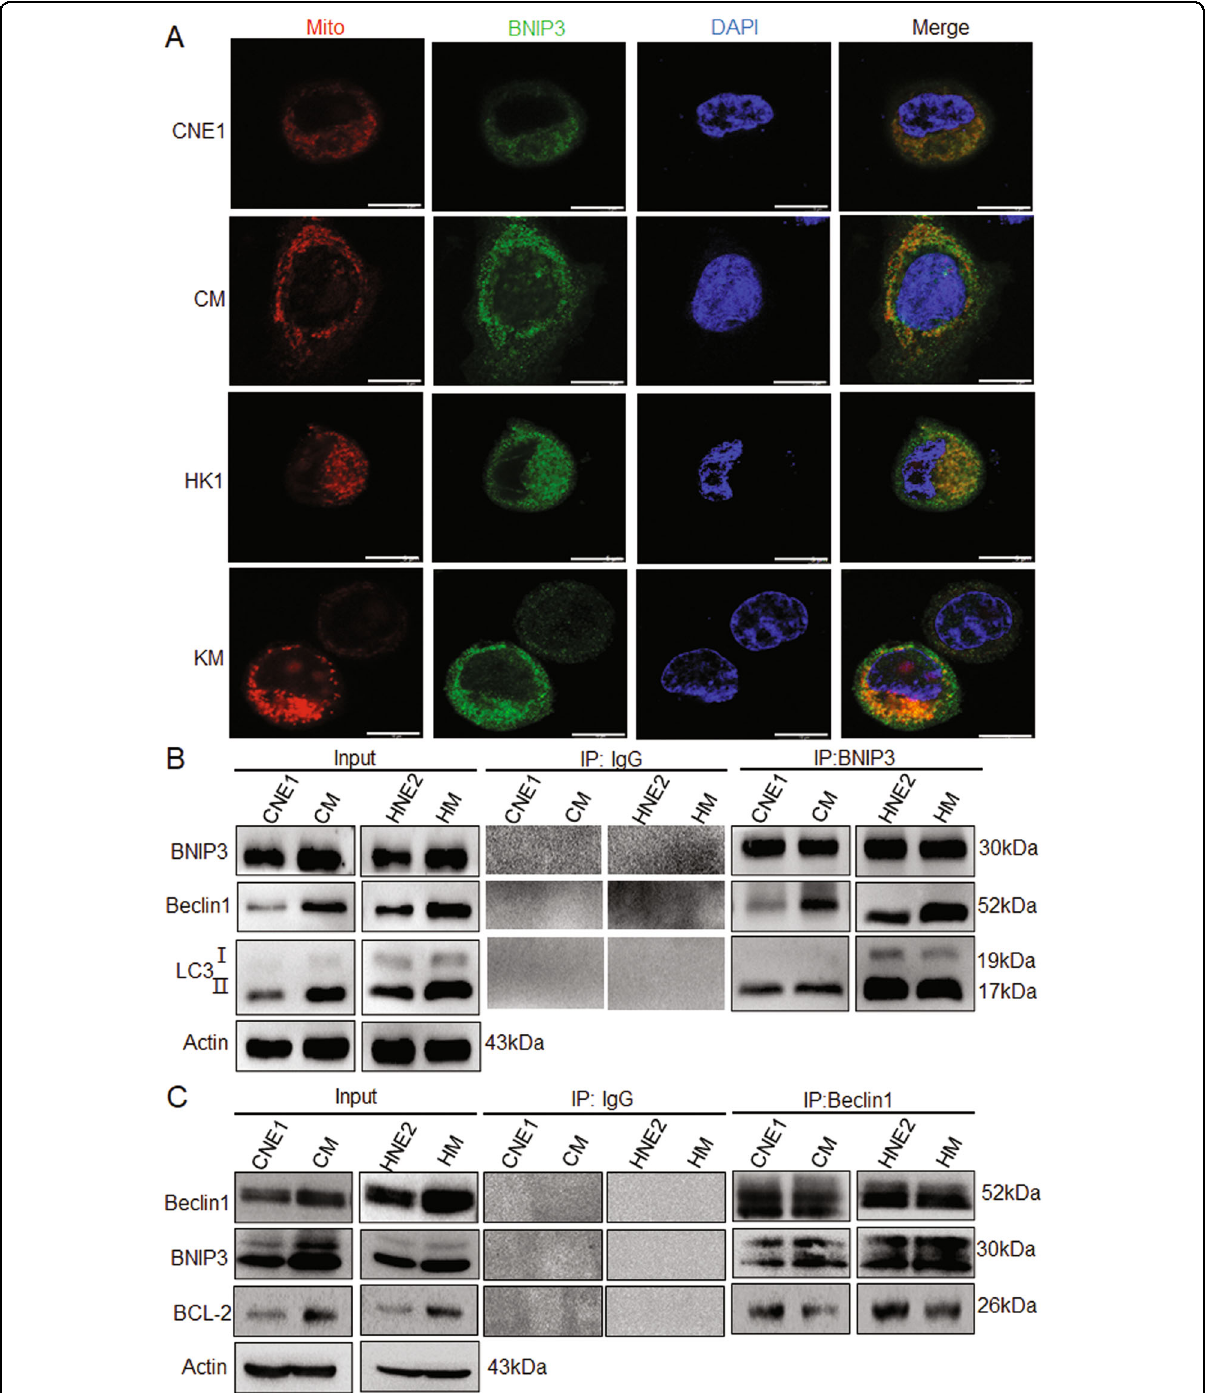
Fig. 6 LMP1-induced BNIP3 triggers autophagy through a dissociated Bcl-2-Beclin1 complex. A After MitoTracker Red staining, the colocalization of BNIP3 in NPC cells CNE1, CM, HK1, and KM was detected by immuno fl uorescence assay. Scale bar: 10 μ m. B The interaction of BNIP3 with Beclin1 and LC3II was detected by Co-IP. C The interaction of Beclin1 with BNIP3 and Bcl-2 was detected by